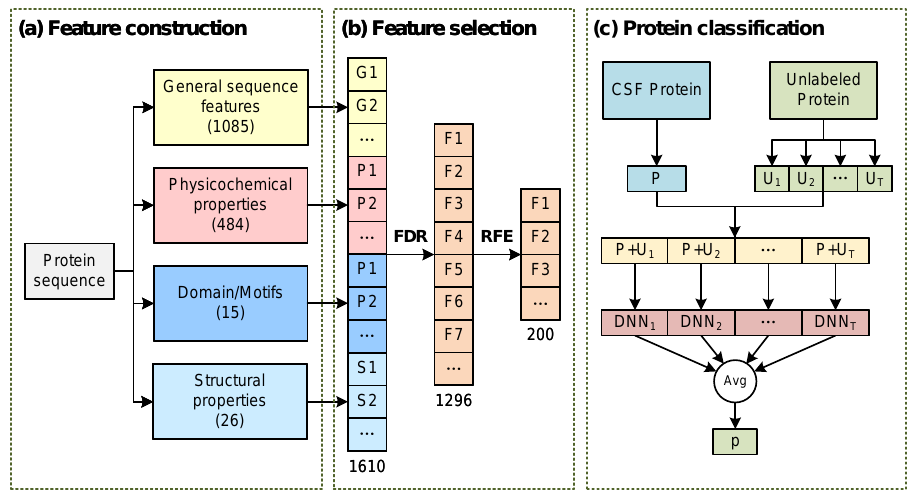
Figure 5. The framework to predict proteins in CSF. ( a ) Feature construction collects four groups of features for each protein; ( b ) feature selection selects the important and effective features for the protein classification; ( c ) protein classification models and predicts the proteins in CSF based on DNN and bagging